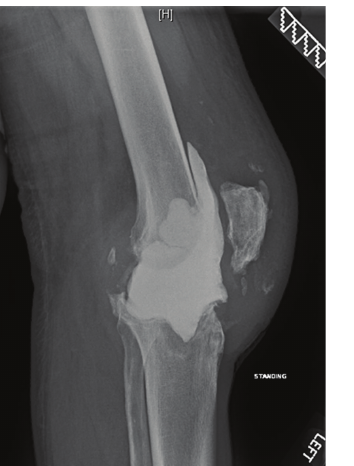
Figure 3: Lateral X-ray of the left knee after the first-stage revision with an antibiotic-impregnated cement spacer 6 months after initial